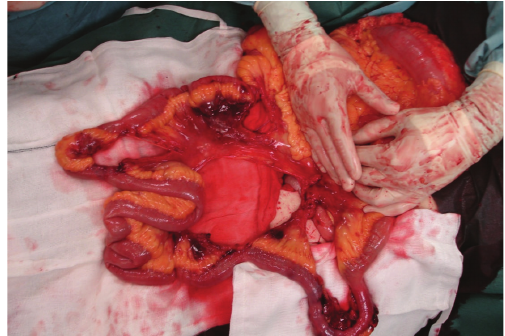
Figure 1: Intra-operative images from Case 1. Small bowel mesen- teric shearing injury with devascularisation resulting in small bowel compromise.